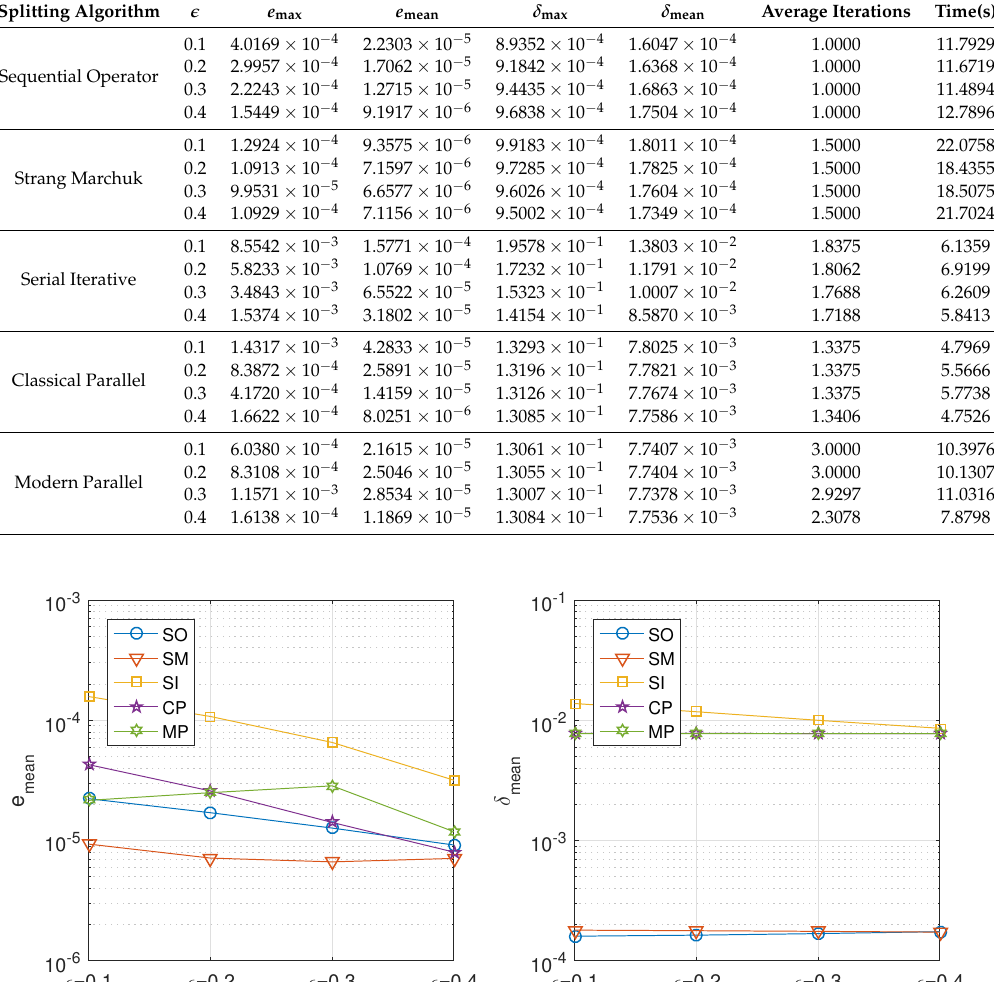
Table 21. Fractional diffusion equation. Results for the mixed decomposition with 20 subintervals in each spatial direction, 320 time steps, and different values of (cid:101) .